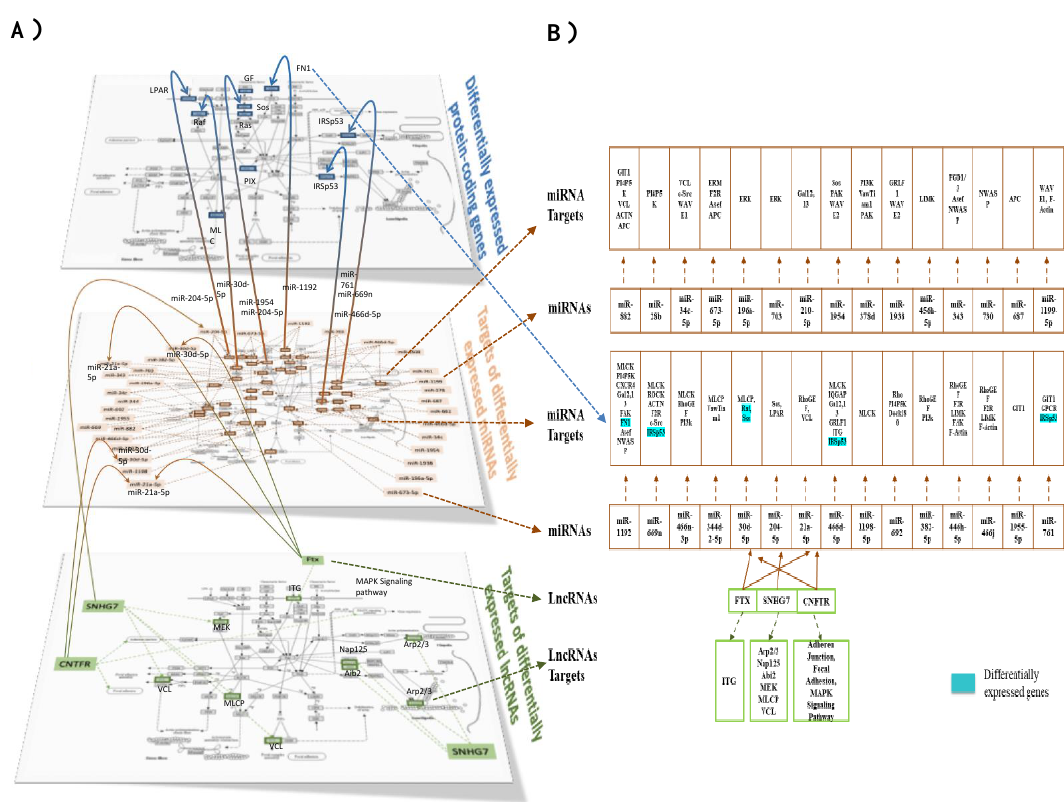
Figure 8. Regulation of the actin cytoskeleton pathway by di ff erentially expressed genes, miRNA, andlncRNA. (A) Integrationanalysisshowingdi ff erentiallyexpressedgenes(bluesquares), di ff erentially expressed miRNAs (brown squares) and their targets (brown broken arrows), and di ff erentially expressed lncRNAs (green squares) and their targets (green broken arrows). Potential interactions between genes, miRNA, and lncRNAs are also shown. ( B ) Amplification of the list of di ff erentially expressed genes (highlighted in blue), miRNAs and their targets, and lncRNAs and their targets, regulating the actin cytoskeleton